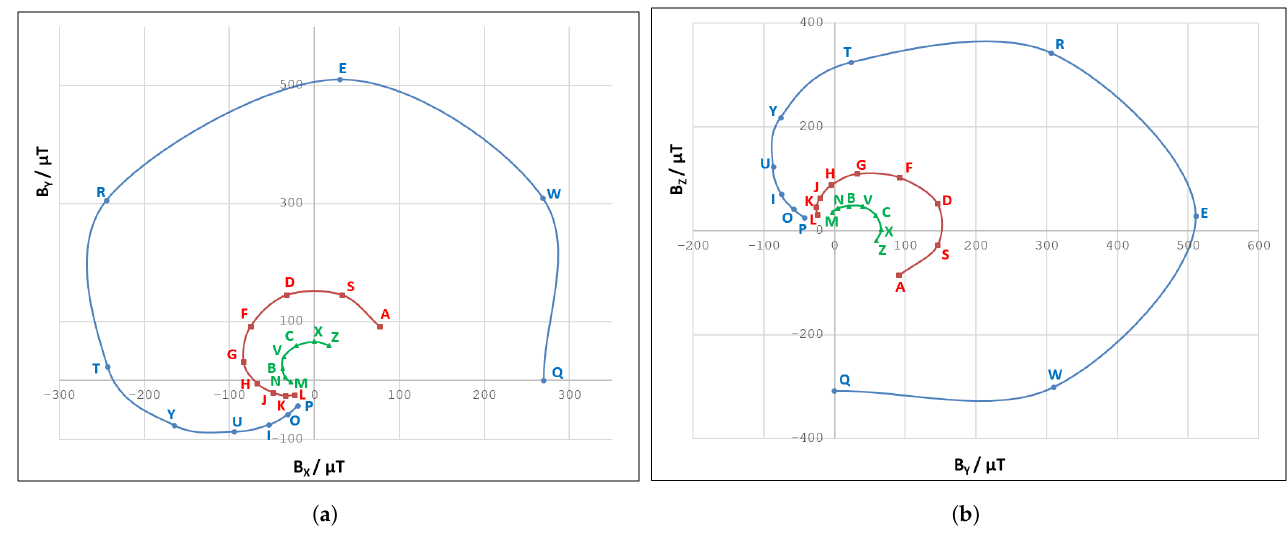
Figure 9. ( a ) The results of magnetic field fingerprinting on a virtual keyboard mockup (in B x / B y plane). ( b ) The same results plotted in B y / B z plane.